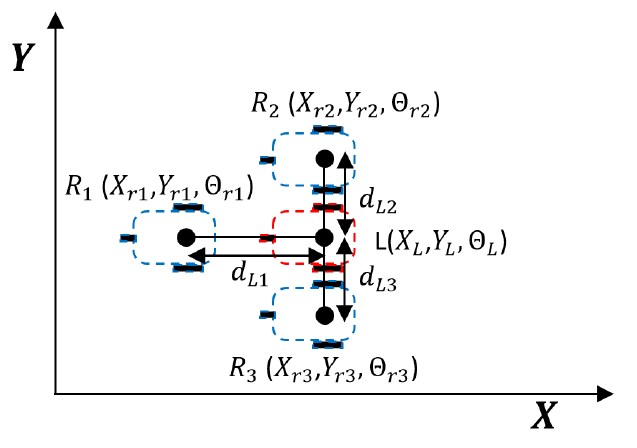
Figure 3. Main variables describing the formation strategy: in blue color the reference poses of each robot R n ( X rn , Y rn , Θ rn ) , which are generated according the position of the Virtual Leader L ( X L , Y L , Θ L ) in